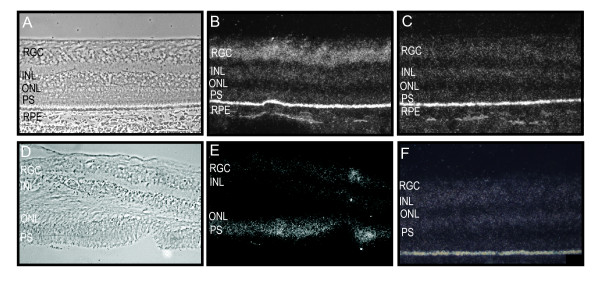
EpoR mRNA expression in the posterior normal (A-C) and diabetic (D-F) retina. A, Phase contrast micrograph of a normal human retina. B, Anti-sense RNA probes for EpoR in normal retina. C, Control sense RNA probes for EpoR in normal retina demonstrates expression in the retinal ganglion cell layer. D, Phase contrast micrograph of a diabetic human retina with an artifactual detachment. E, Anti-sense sense RNA probes for EpoR in diabetic retina. F, Control sense RNA probes for EpoR shows decreased expression in the RGC layer and an increase in the photoreceptor segments. Abbreviations: RGC, retinal ganglion cell layer; INL, inner nuclear layer; ONL outer nuclear layer; RPE, retinal pigment epithelium layer; PS, photoreceptor segments.